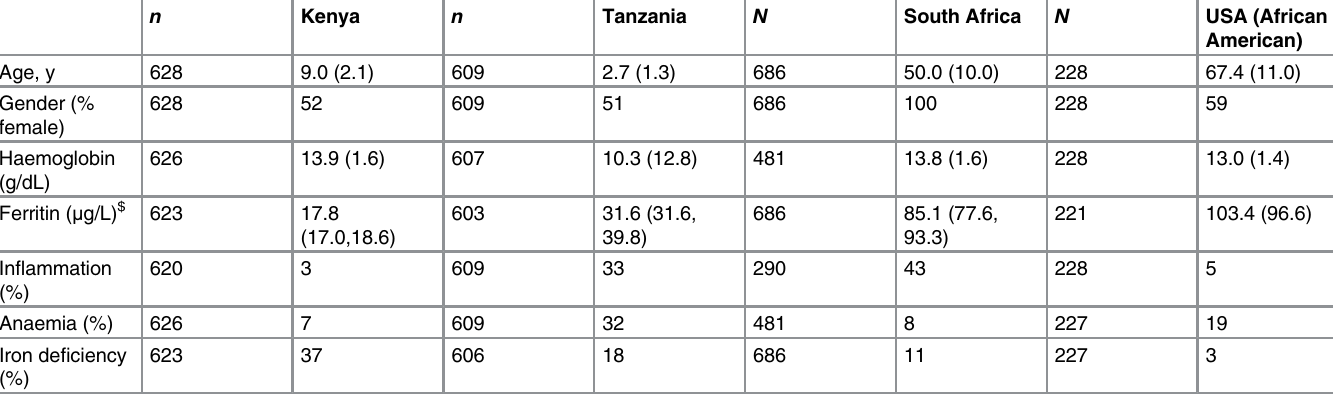
Table 1. General characteristics of the study participants in the four